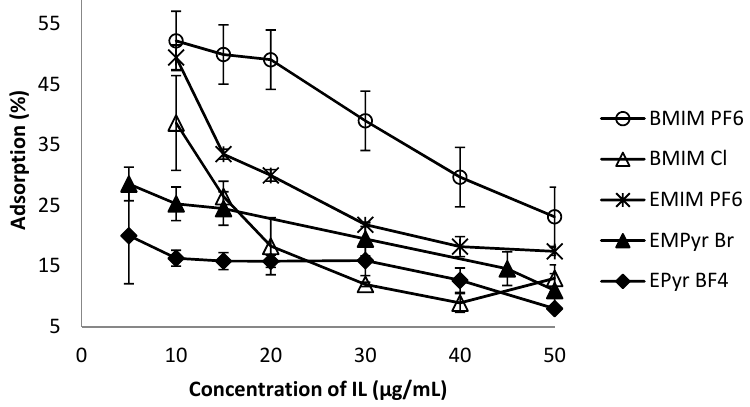
Figure 2. Influence of ionic liquid concentration on adsorption efficiency.